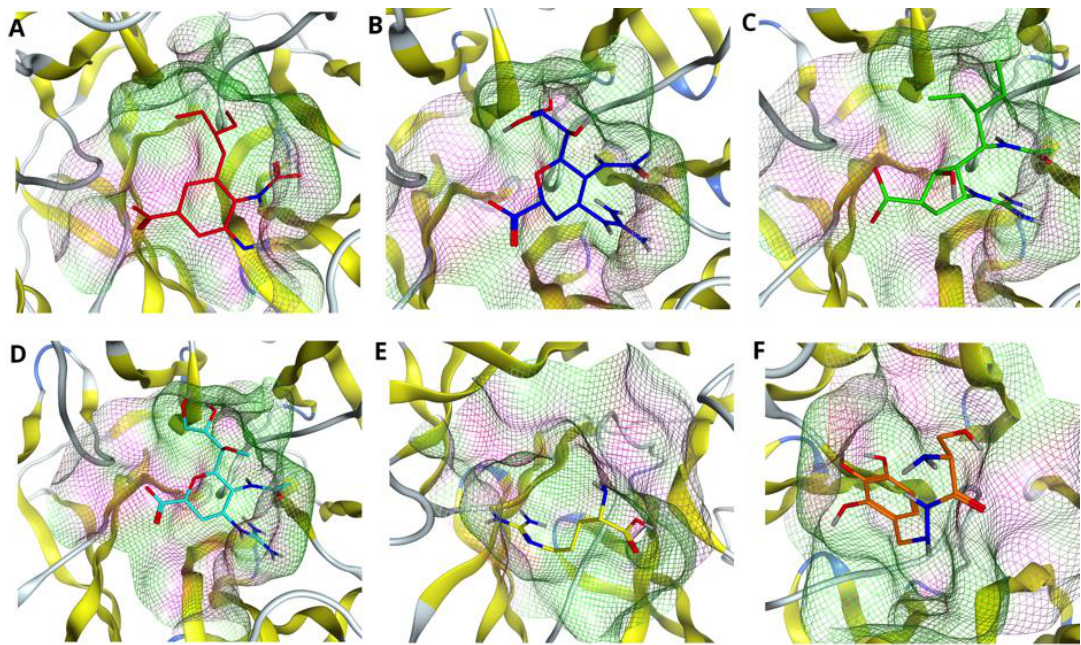
Figure 4. Comparing drug fit to single mutated NA binding pocket. Accommodation of the drugs ( A ) Oseltamivir (red), ( B ) Zanamivir (blue), ( C ) Peramivir (green), ( D ) Laninamivir (cyan), ( E ) L-Arginine (yellow) and ( F ) Benserazide hydrochloride (orange) in the pocket of H7N9 neuraminidase with single R372K mutation.